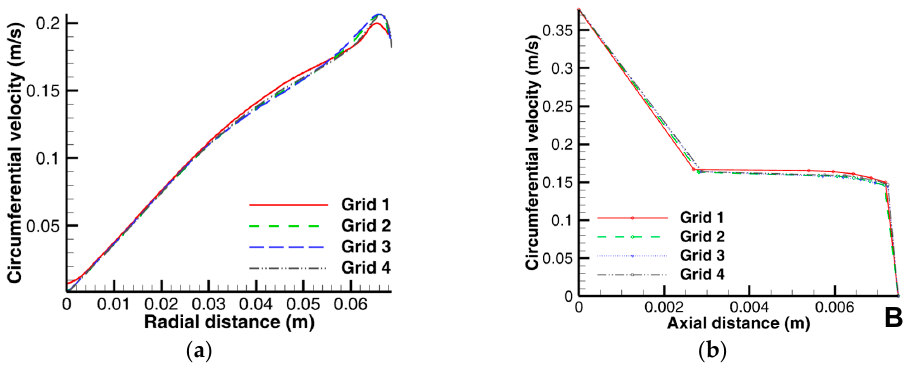
Figure 4. Influence of the computational grid size on the computed tangential velocity profiles on radial Y-Z and axial X-Z planes for the RNG k - ε model at 70 rpm for ( a ) x = 0.003725; ( b ) y = 0.045.